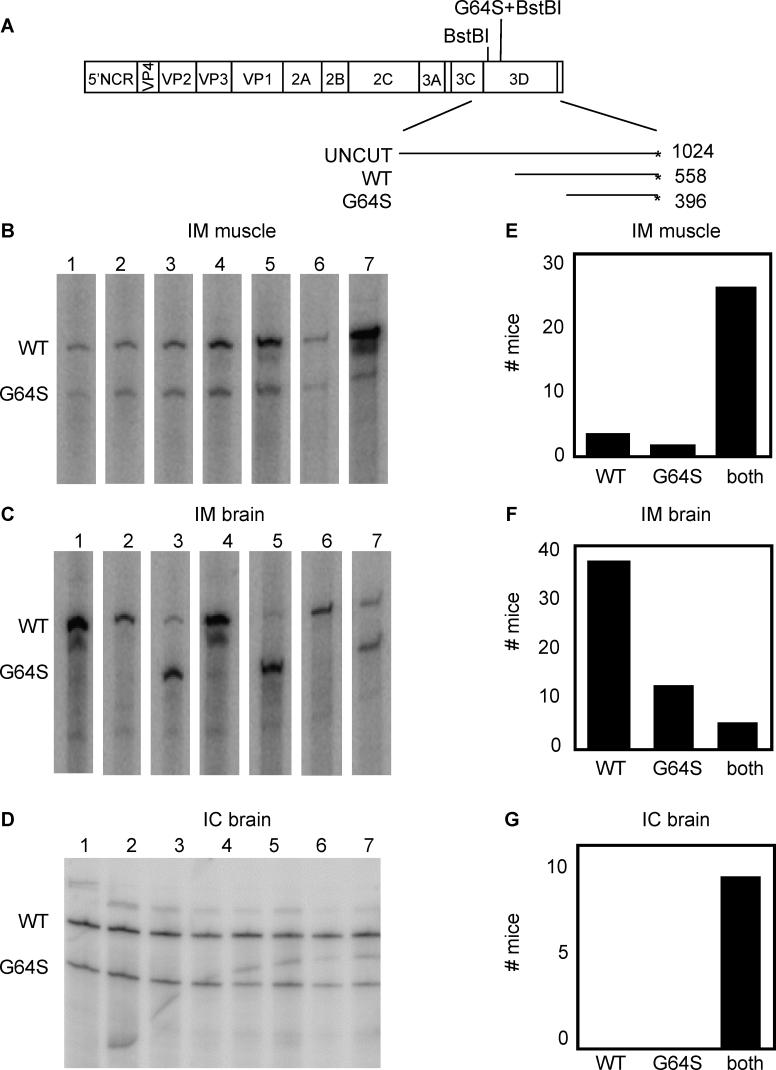
Viral Competition Assay in Poliovirus Receptor-Expressing Mice(A) Diagram of poliovirus genome showing BstBI restriction enzyme sites within the coding region for 3D polymerase. Digestion of 1,024-bp 32P end-labeled (*) RT-PCR products yields a 558-bp labeled band for wild-type and a 396-bp labeled band for 3D-G64S. 6-wk-old mice were given IM injections with a 1/2 mixture of wild-type to 3D-G64S poliovirus (2 × 107 PFU total virus per mouse). Tissues were harvested when animals first developed paralysis, between days 3 and 5. PCR products were end-labeled with 32P during synthesis by inclusion of a radiolabeled downstream primer and products were digested with BstBI before electrophoresis on a denaturing polyacrylamide gel. Products from muscle samples from the IM infections are shown in (B) while products from brain samples of the IM infections are shown in (C). In (D), 2-wk-old mice were given IC injections with a 1/1 mixture of wild-type to 3D-G64S virus, and brain tissue was harvested when mice became lethargic or paralyzed. For (B), (C), and (D), representative gels are shown. In (E), (F), and (G) all mouse data obtained from the types of experiments shown in (B), (C), and (D), respectively, are quantified, and show the total number of mice whose tissues contained predominately wild-type virus, 3D-G64S virus, or both. The total number of mice per condition are as follows: IM-muscle samples, 31 mice; IM-brain samples, 54 mice; IC-brain samples, 10 mice.DOI: 10.1371/journal.ppat.0010011.g002